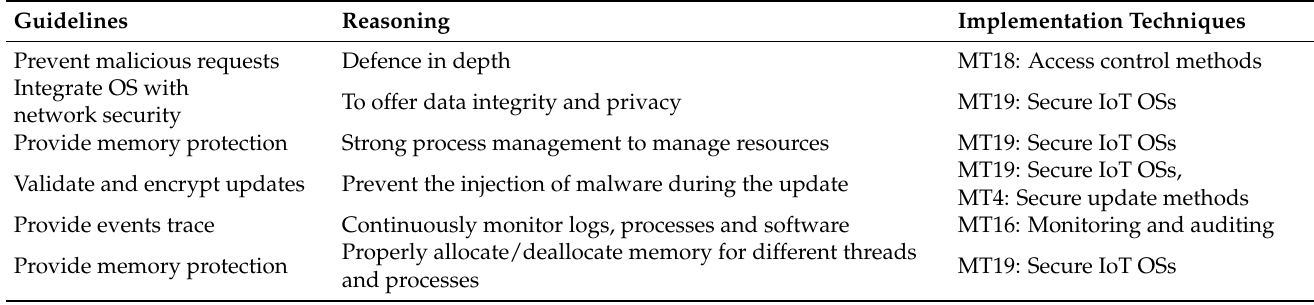
Table 9. A summary of the suggested guidelines for software layer along with their